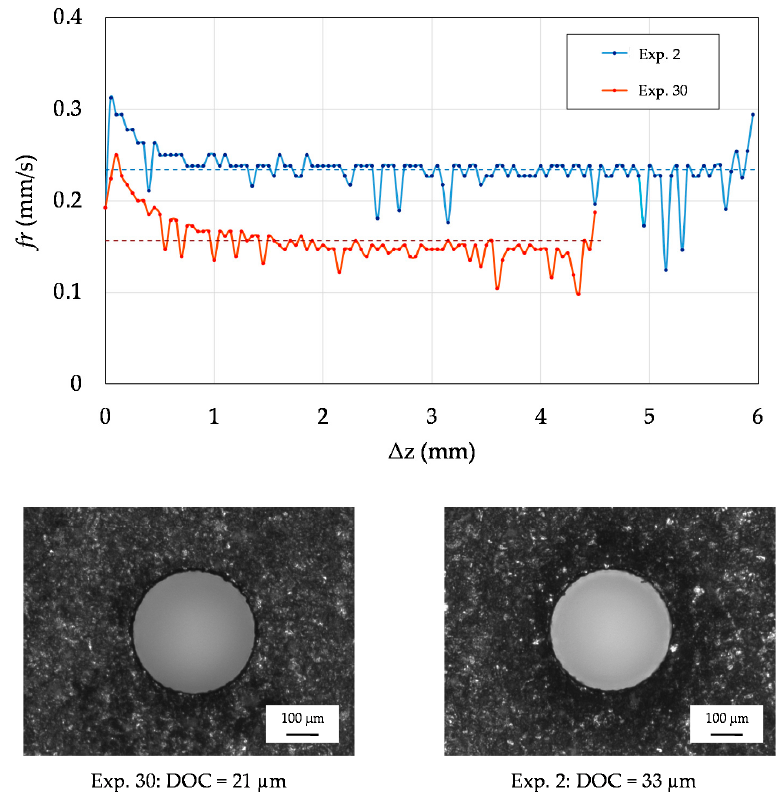
Figure 11. Evolution of fr during drilling. The data points represent the in-line monitored values of fr , while the dashed lines correspond to the average values. The evolution of fr and the hole inlets relative to two experimental runs are shown. Levels of the factors in Experiment 2: A = − 1, B = +1, C = − 1, D = +1. Levels of the factors in Experiment 30: A = − 1, B = − 1, C = +1, D = − 1.